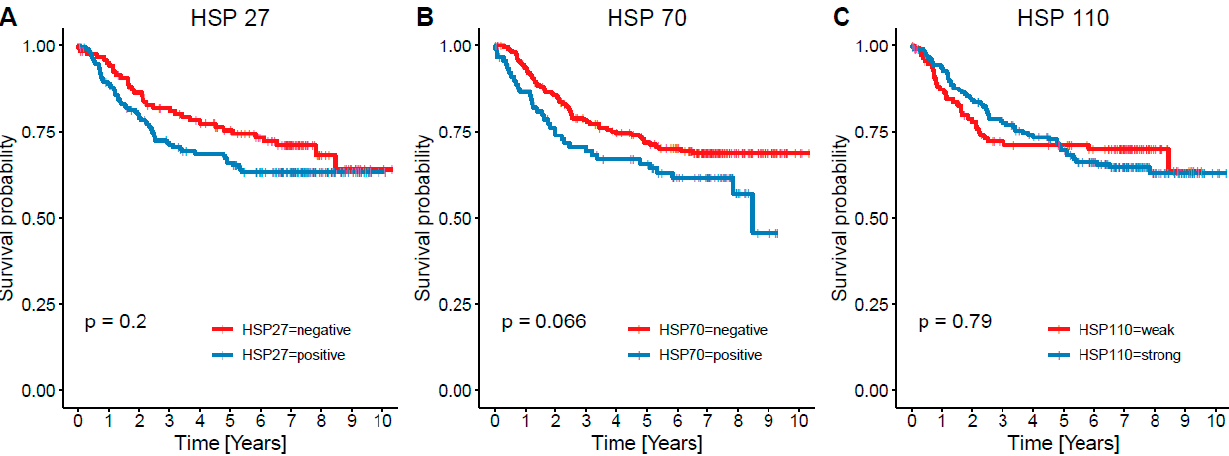
Figure 3. Kaplan–Meier curve documenting cancer specific survival (CSS) in relation to heat shock protein (HSP) status, both HSP27 and HSP70 displayed adverse effect on survival, but was insignificant.